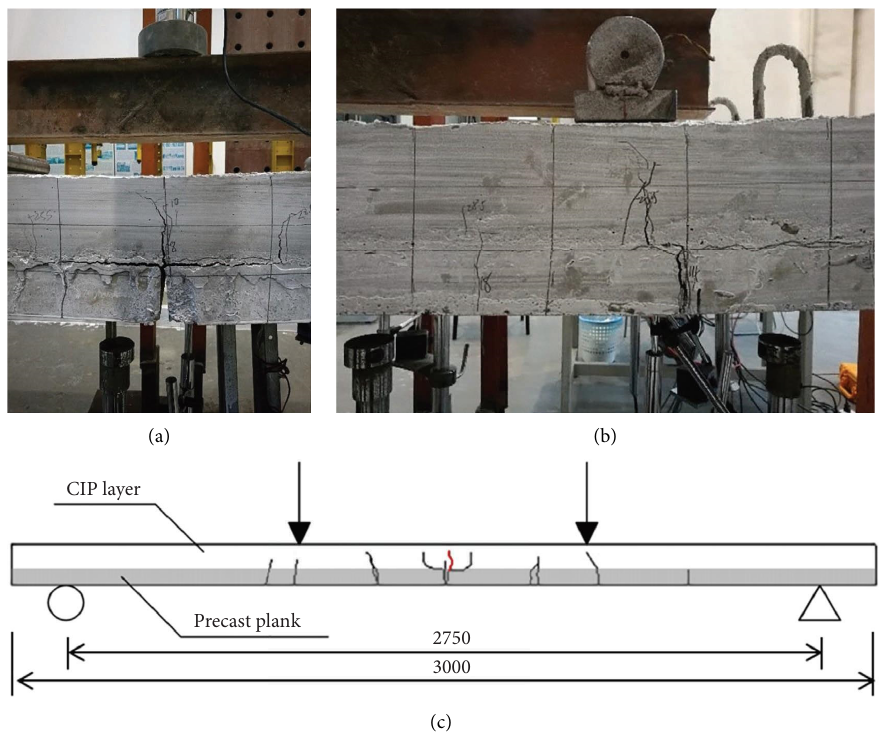
Figure 10: Failure phenomenon of LGSB2. (a) Cracking at midspan. (b) Cracking in the precast plank. (c) Crack pattern.